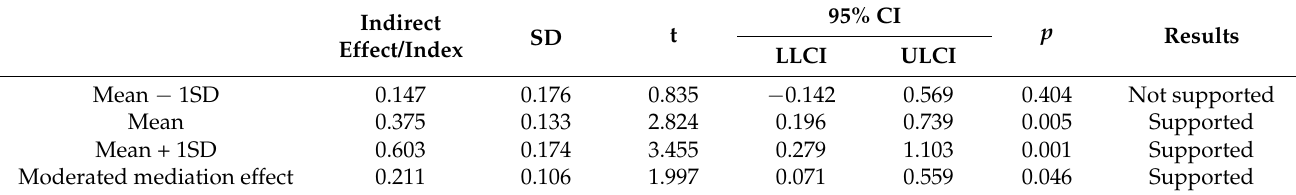
Table 6. Moderated mediation effect.